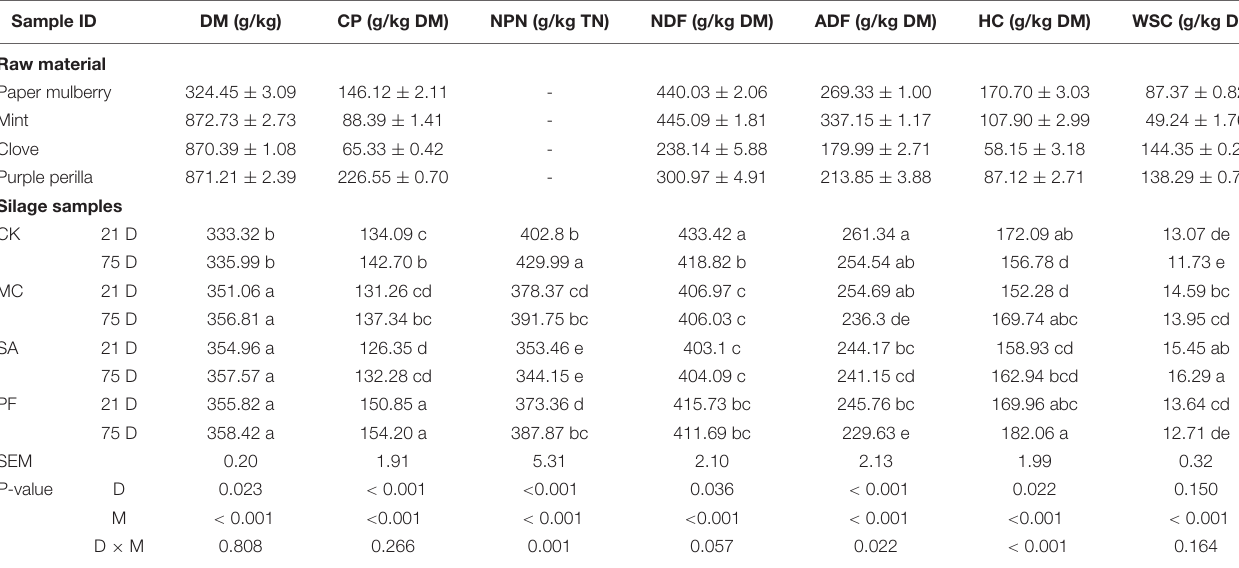
TABLE 1 | Chemical characteristics of raw materials and silages after 21 and 75 days of